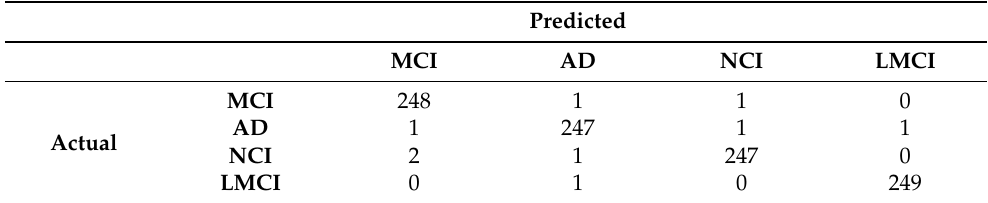
Table 3. Confusion